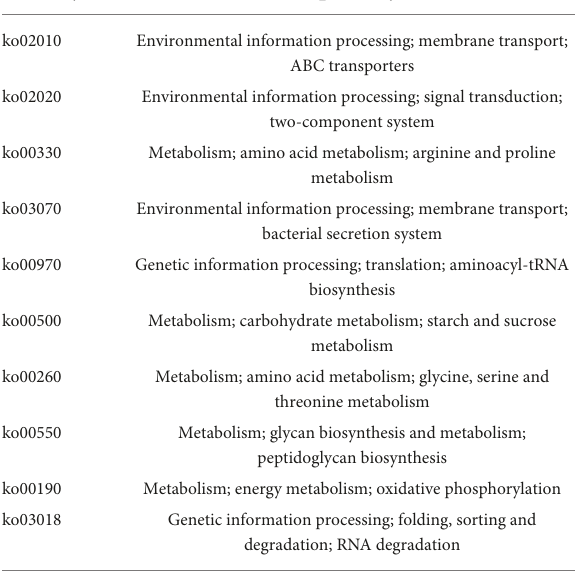
TABLE 4 List of metabolic pathway functions. Pathway Metabolic pathway